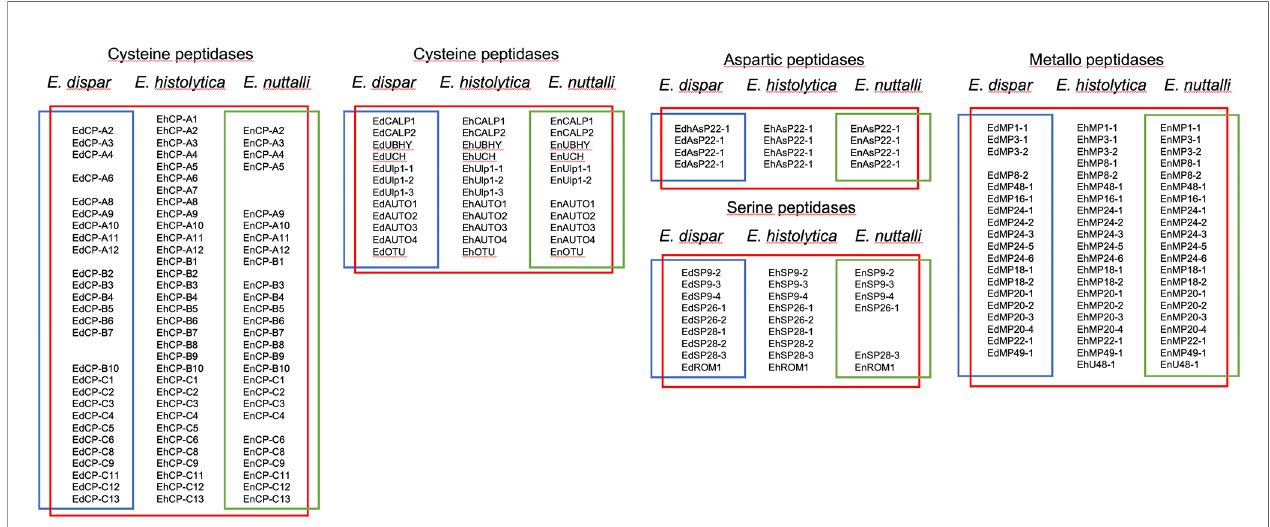
FIGURE 3 | Cysteine, asparagine, serine and metallopeptidases of E. histolytica , E. dispar and E. nuttalli (for more details see Table S9